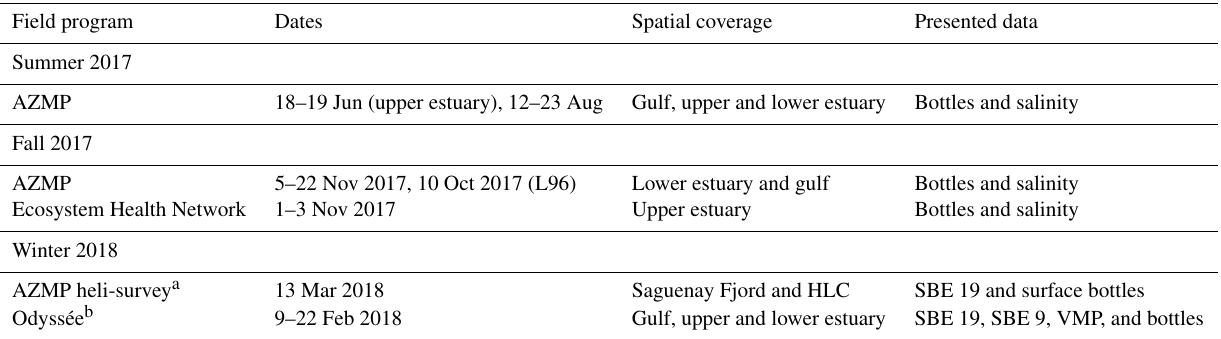
Table 1. Overview of measurement campaigns. All campaigns included CTD profiling with pumped Sea-Bird instruments (SBE 9 and/or SBE 19plus V2). Bottles provided in situ nutrients concentrations, in particular nitrate. We present phosphate and silicate only during winter. The accuracy of the SBE 19’s temperature and conductivity was 0.005 ◦ C and 0.0005Sm − 1 . For the SBE 9 and SBE 3F–SBE 4-C on board the VMP, the accuracy of temperature and conductivity was 0.001 ◦ C and 0.0003Sm − 1 . The accuracy of the pressure sensors was 0.015% of the full scale for the SBE 9 and 0.1% for the SBE 19 and VMP.